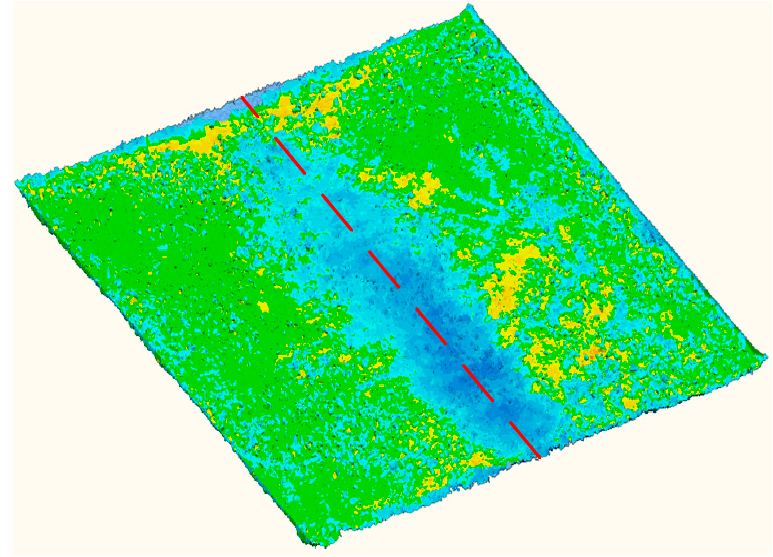
Figure 7. Schematic diagram of the model measuring line.